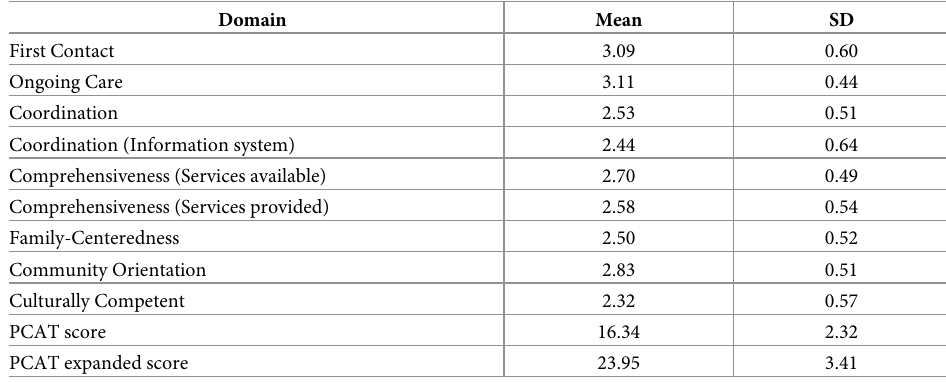
Table 3. Primary care assessment from physicians’ perspectives (PCAT score) (N =